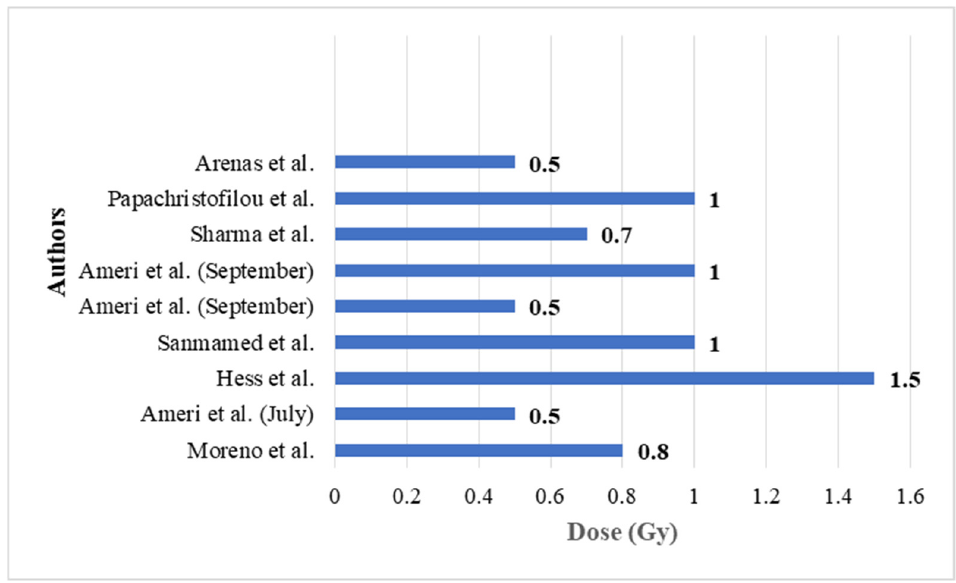
Figure 3. Radiation dose in the 9 clinical trials included in this review.